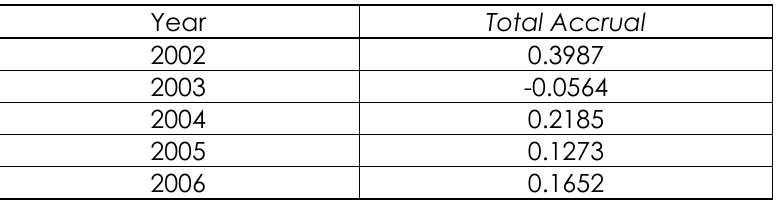
Table 2. Mean total accrual (Healy